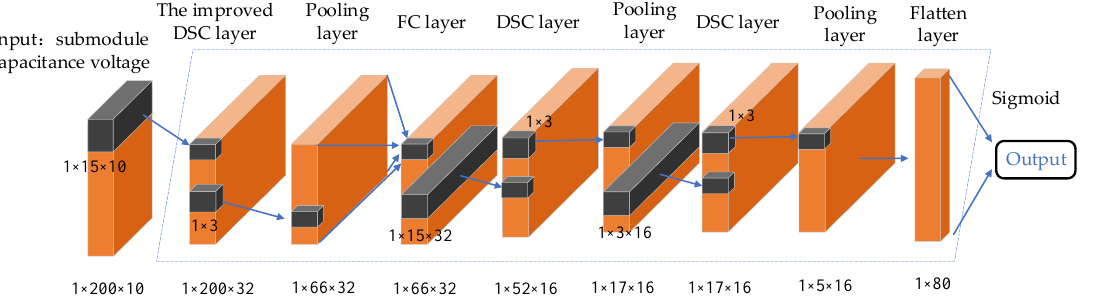
S o f t m a x Figure 9. Schematic diagram of fault classification neural network.